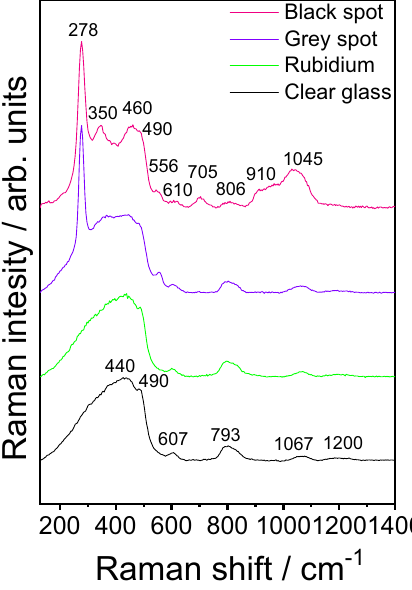
Figure 5. Raman spectra were recorded in different spots of the contaminated quartz window of the rubidium vapor cell.